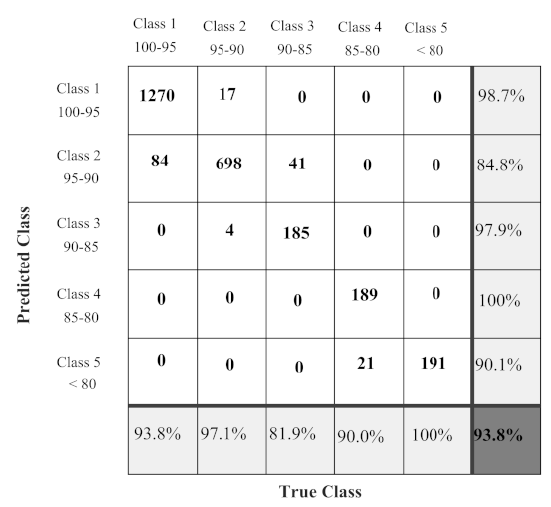
Figure 17. Confusion matrix for performance analysis of ANN-based classifier under the step charging current profile validation. The diagonal cells are correctly classified buffers. The last row with gray background is the TPR. The last column with gray background is the precision per class. The bottom right cell with dark background is the total accuracy.